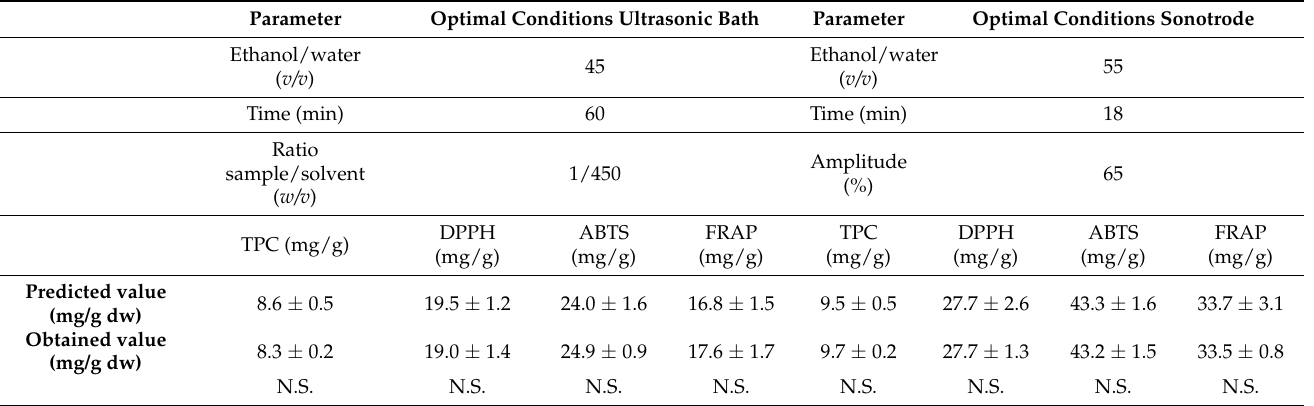
Table 3. Optimal conditions selected and models predicted values with the obtained values expressed with the mean and the standard deviation of ultrasonic bath and